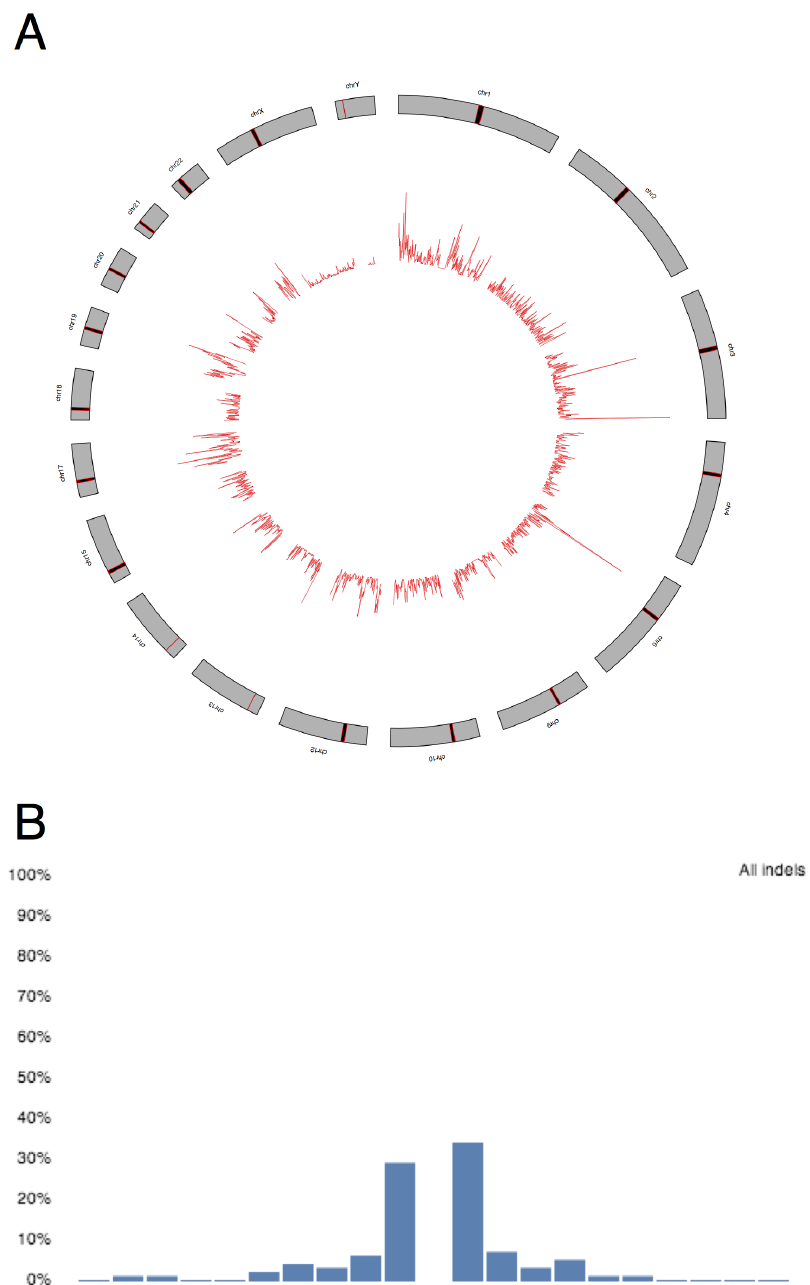
Figure 2. Sample output. STORMSeq provides basic visualization for summary statistics, such as (A) genome-wide SNP density and (B) size distribution of short